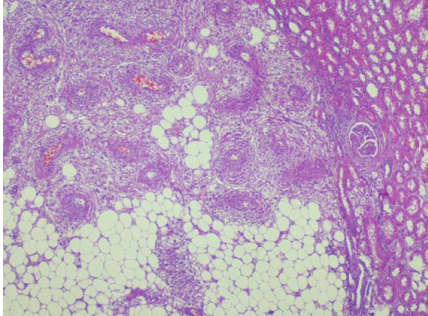
Figure 3: Microscopic view of the mass.